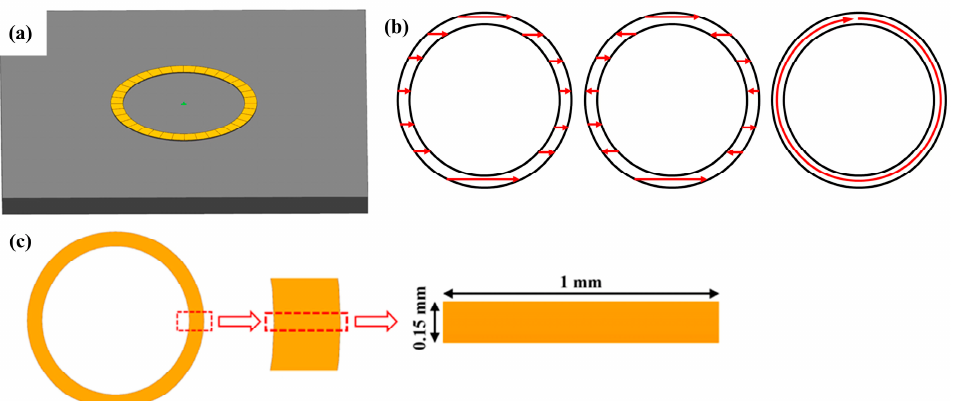
Figure 2. ( a ) 3D finite element model; ( b ) unidirectional, bidirectional and ring scanning strategies; ( c ) parts of the ring model.